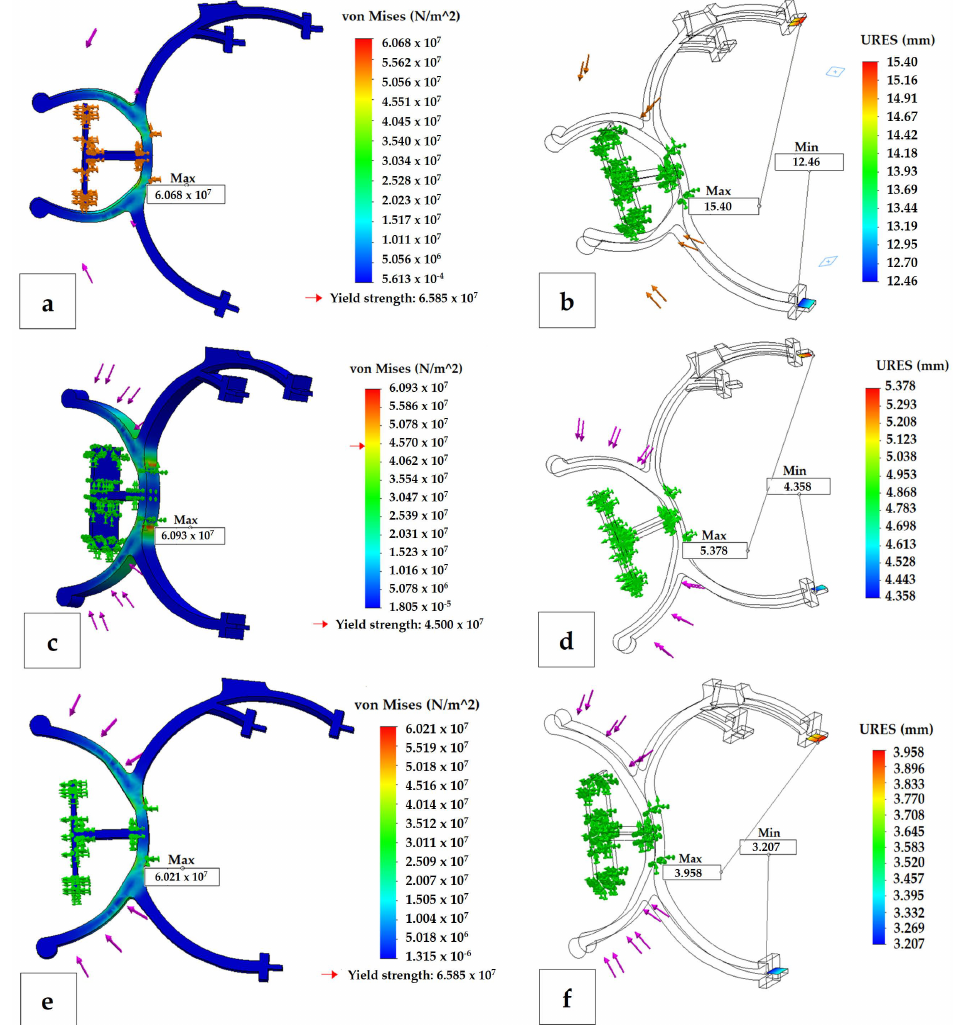
Figure 3. Comparison of obtained mechanical characteristics results for three investigated materials (35 N applied force in all cases): ( a )-TPU mechanism Von Mises stress results; ( b )-TPU mechanism displacement results between gripping elements; ( c )-ABS mechanism Von Mises stress results; ( d )-ABS mechanism displacement results between gripping elements; ( e )-PLA mechanism Von Mises stress results; ( f )-PLA mechanism displacement results between gripping elements.